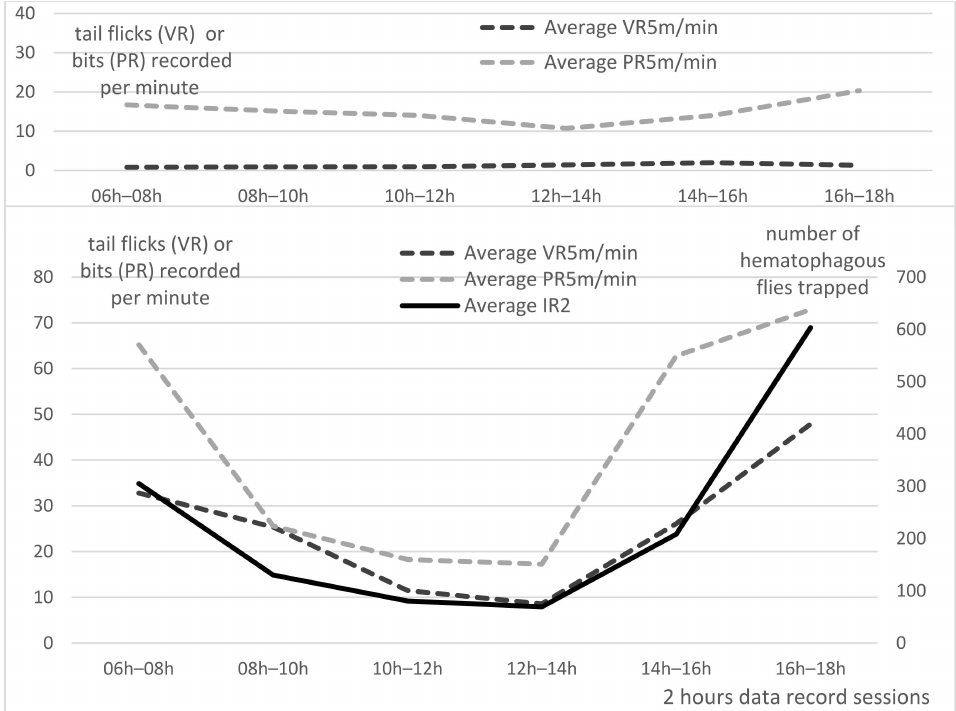
Figure 5. Averaged per minute tail flicks established by visual records (VR5m/5) and pedometer records (PR5m/5) on 6 feeder cattle and insect records (IR2), per 2 h data record sessions, registered for 21 days, from 2 August 2016 to 17 November 2016, in Group A ( up ) and B ( down ).